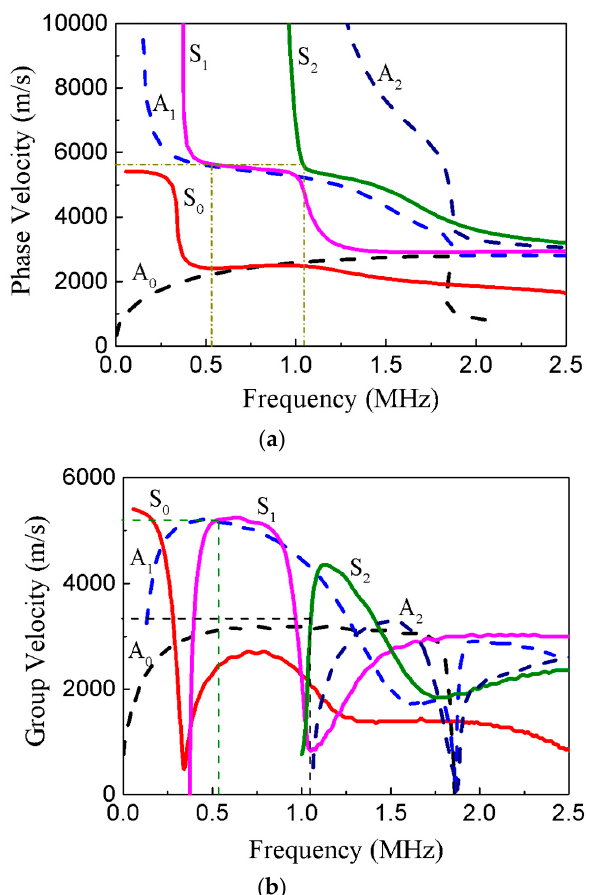
Figure 2. The d ispersion curve of the tri-layer adhesive structure. (a) Phase velocity versus the frequency and (b) Group velocity versus the frequency. The solid lines represent the symmetric modes; the dashed lines represent the anti-symmetric modes.